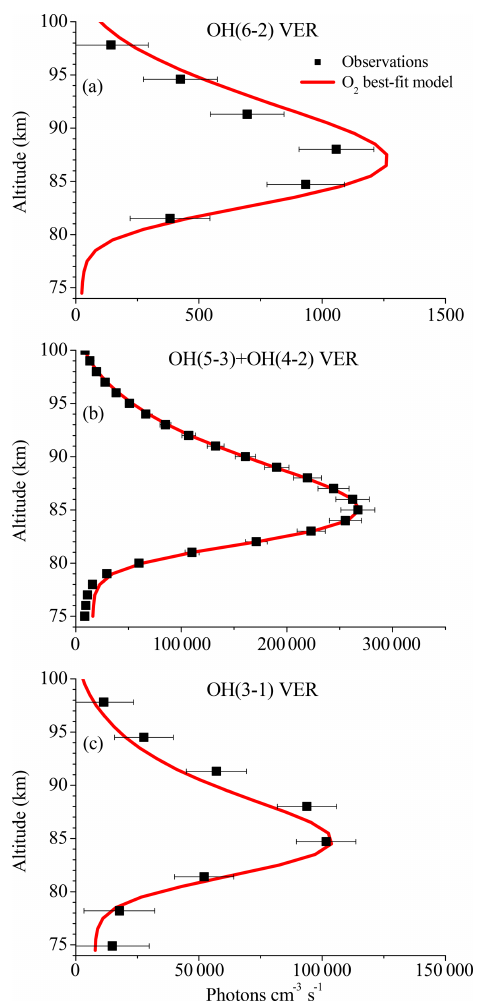
Figure 4. Same as Fig. 1 but for the O 2 best-fit model. Note that Fig. 4a is identical to Fig. 3a but was plotted again for